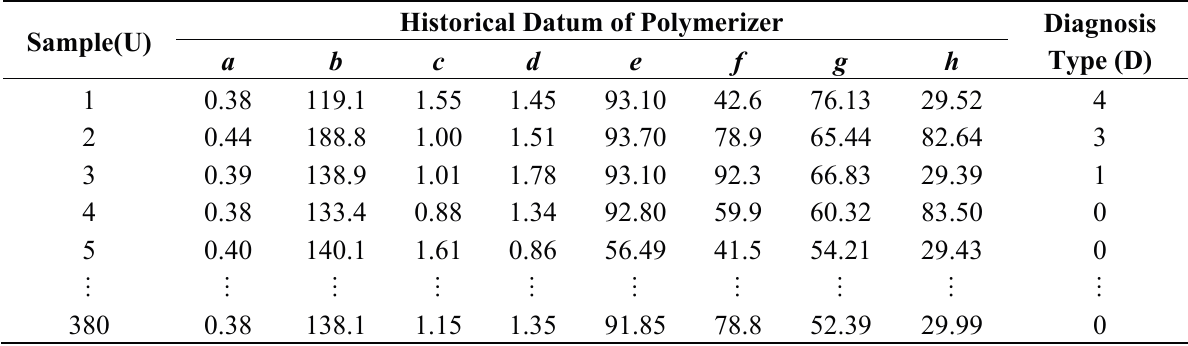
Table1. Historical data of polymeric